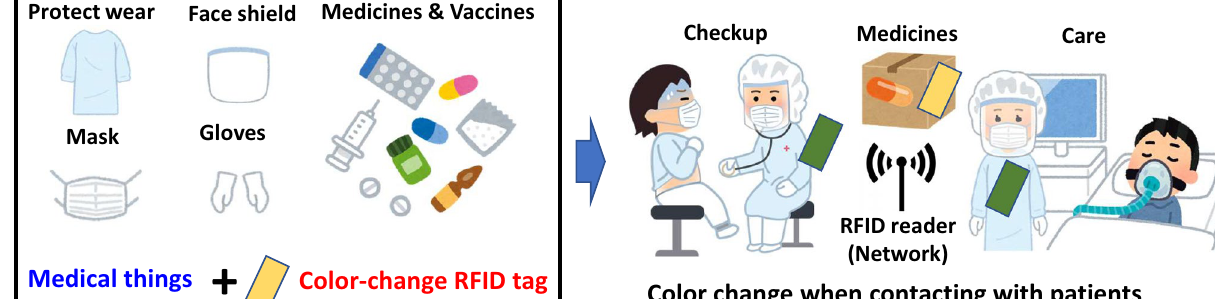
Figure 1. Visual management of medical things using a color-change RFID